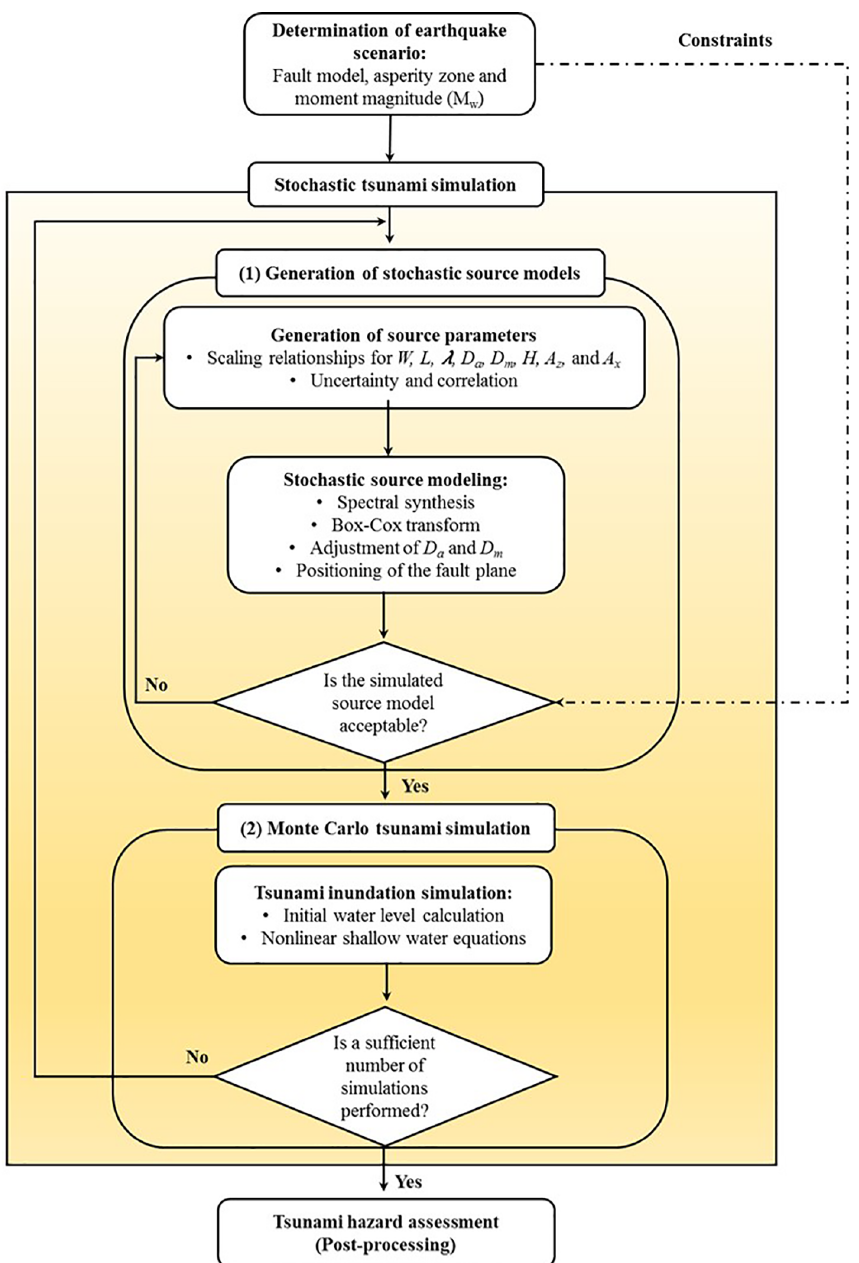
Figure 2. Procedures of stochastic tsunami